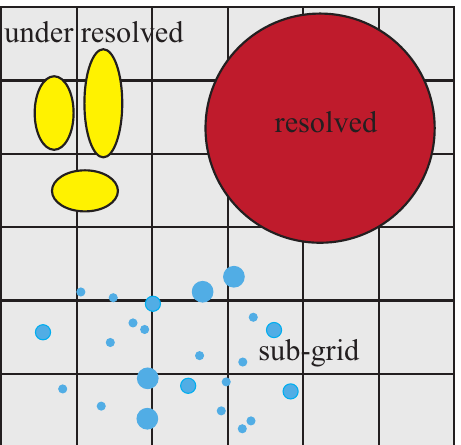
Figure 1. Schematic of three interface types with respect to the computational grid: the fully-resolved, under-resolved, and sub-grid dispersed